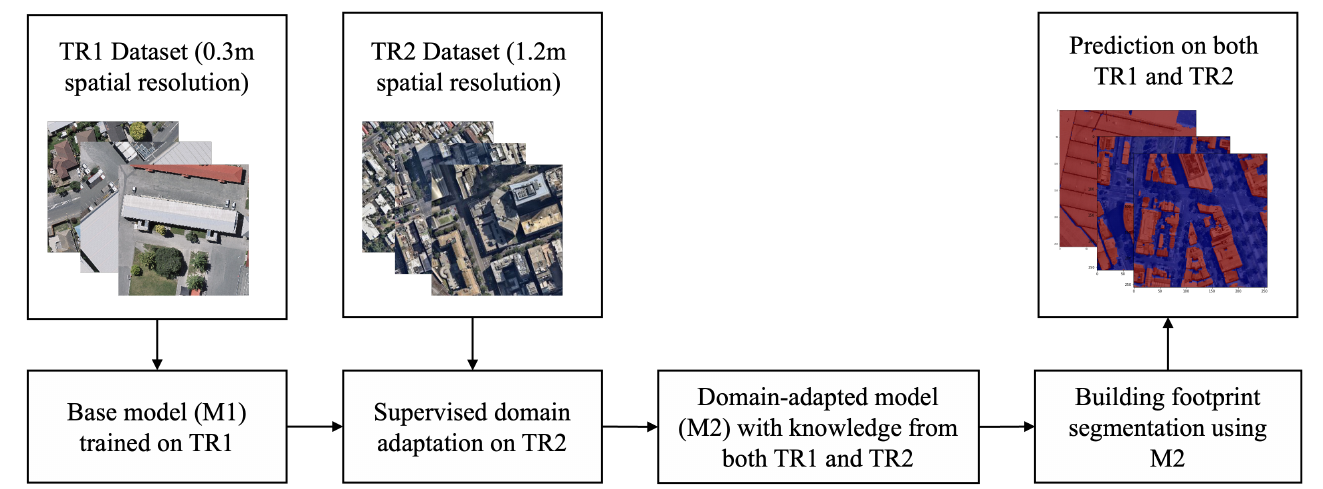
Figure 5. Overall workflow of training and supervised DA of MSA-UNET and